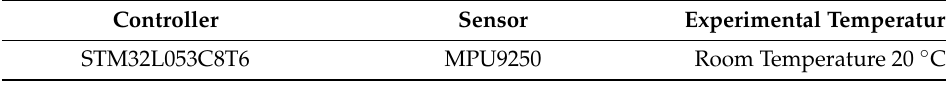
Table 2. System experimental parameters.